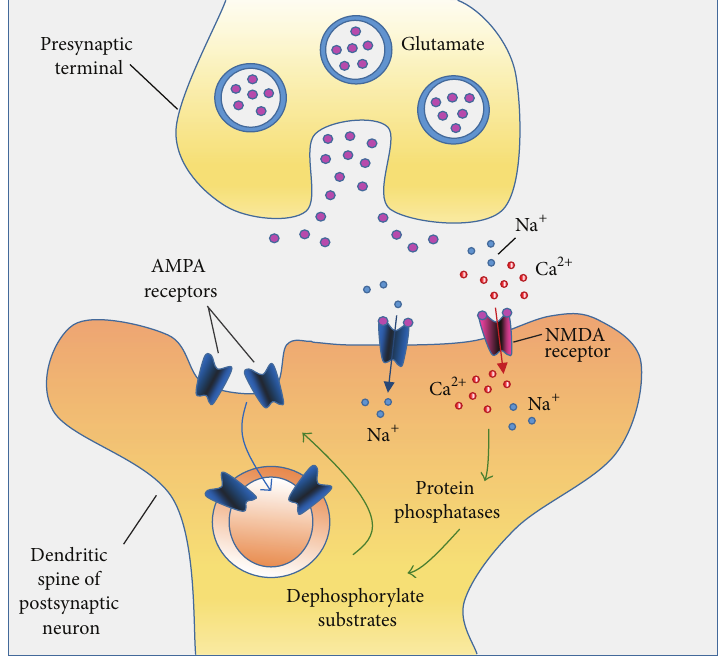
Figure 2: LTD mechanism: (a) Ca 2+ ions enter in small quantities through NMDA receptors. (b) Activation of protein phosphatases. (c) Dephosphorylation of AMPA receptors leads to endocytosis of